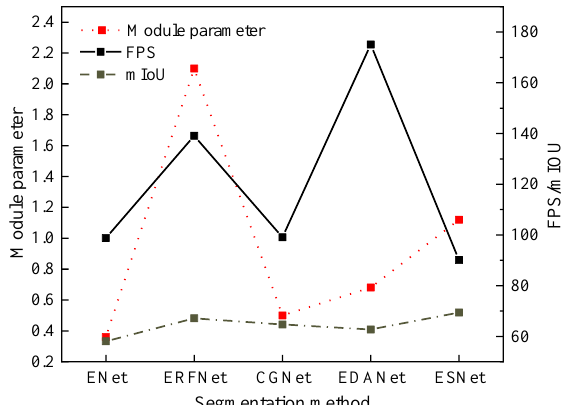
Figure 16. Segmentation comparison results of ESNet on the CamVid test dataset.